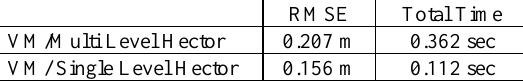
Table 9. VM/Hector SLAM Performance During Second Experiment (Multilevel and single